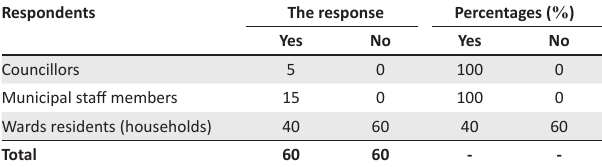
TABLE 2: Summary of the respondents on their response for whether they pay municipal services or not.